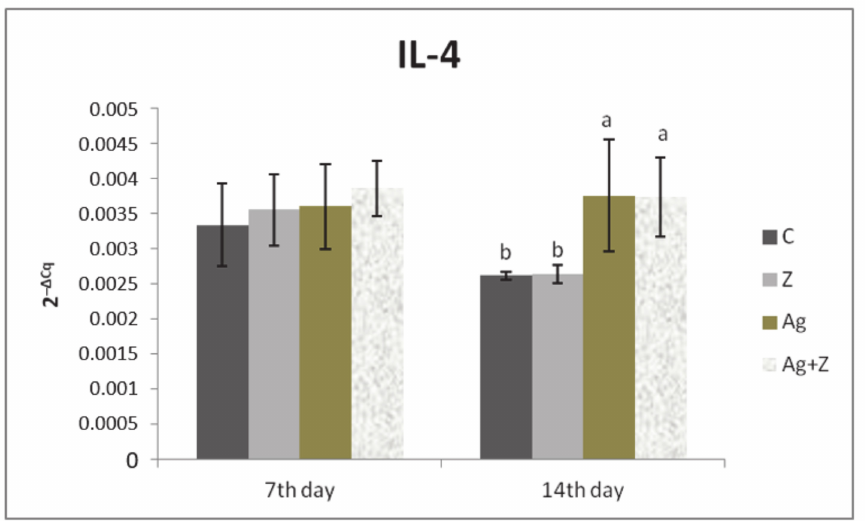
Figure 1. Relative expression of IL-4 gene in the jejunum of chickens treated with inorganic ZnSO 4 and infected by A. galli . Results at each time point are the median of 2 − ∆ Cq . Means with different superscripts are significantly different. ab p < 0.05.